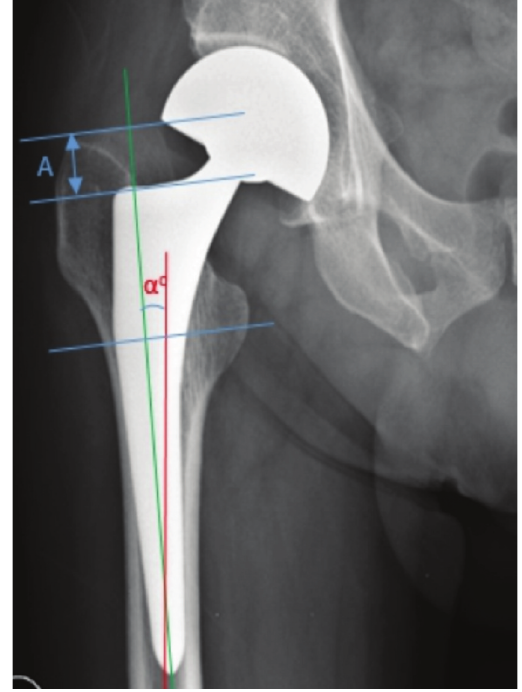
Anteroposterior pre-operative radiograph of a right hip Fig. 3: showing determination CFI and Dorr score.